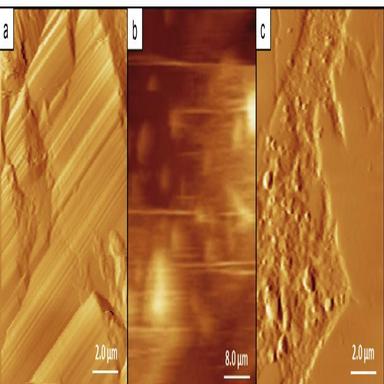
AFM implementation for basalts: imaging of (a) a hammered surface, (b) a powder, (c) a polished surface. Striations in (a) are interpreted to be slickenslide striations. Artifacts in (b) are due to the mobility of grains (Goł. Polishing is the only sample preparation method that provides an interpretable view of mineral topography.